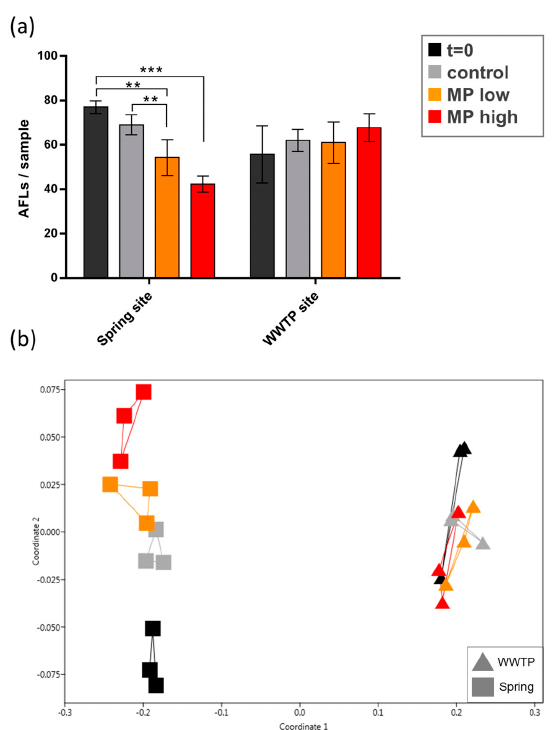
Figure 3. ( a ) Number of Automated Ribosomal Intergenic Spacer Analysis Fragment Length (AFLs) as indicator for bacterial richness in sediments from a spring site and downstream of a wastewater treatment plant (WWTP) before and after treatment with a low (2 mg/g sediment) and high (20 mg/g sediment) dose of PE particles (MP). Significant differences were detected with a two-way ANOVA and Tukey’s multiple comparisons test (** p < 0.01, *** p < 0.001). ( b ) The data set from ( a ) is represented